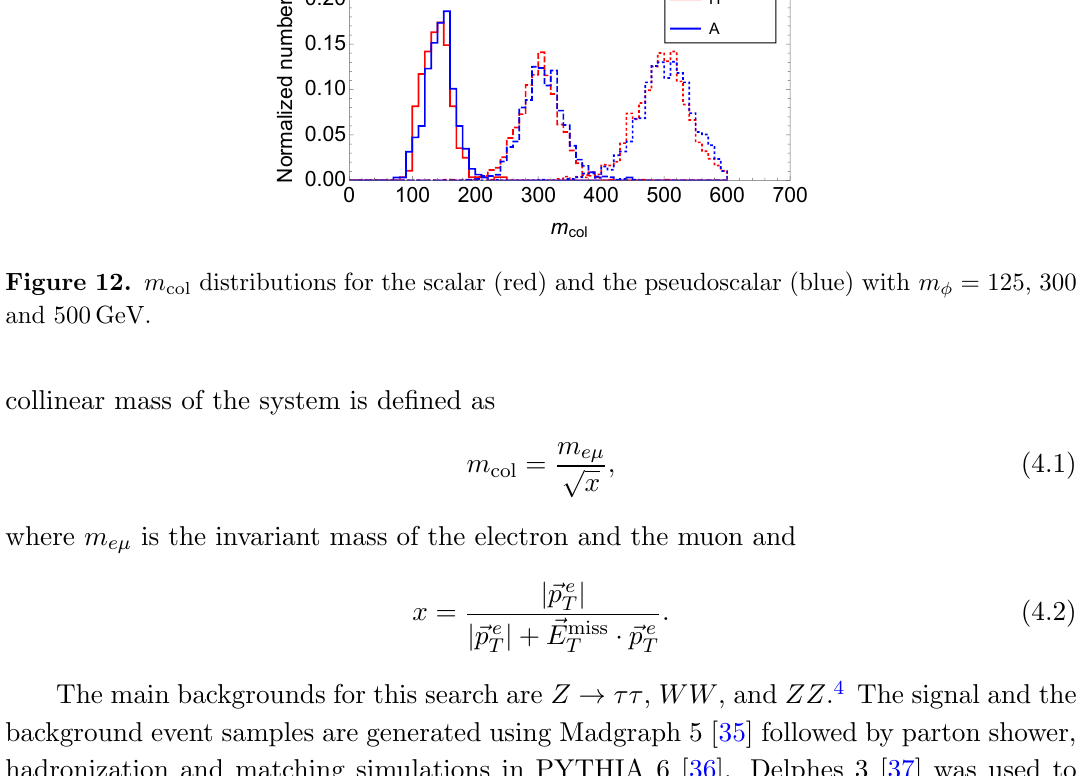
Figure 11. The background for the 8 TeV LHC with 20 fb compared to the CMS simulation [4].